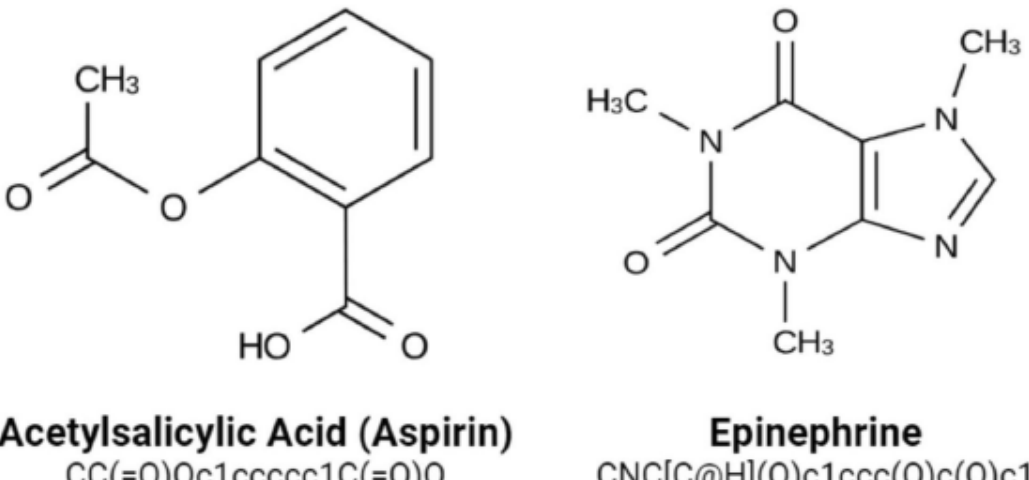
Figure 5. SMILES notations for numerous